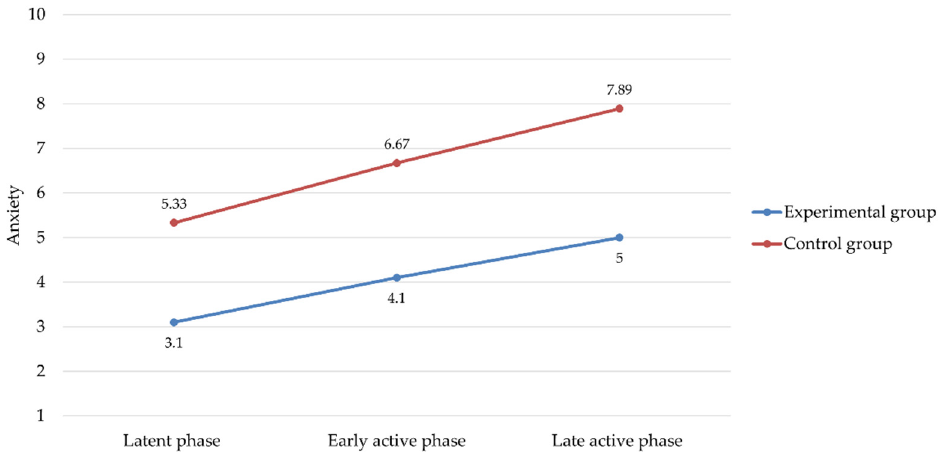
Figure 3. Changes in anxiety scores measured with the Visual Analogue Scale for Anxiety along the stages of labor in experimental and control group.